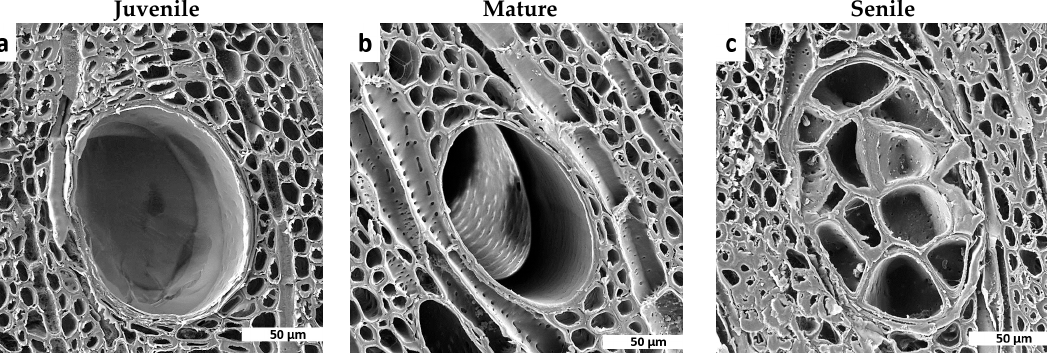
Figure 4. Microphotographs of transverse cuts obtained in scanning electron microscopy (SEM) for the comparison of green tissue-microstructure transitions in Eucalyptus globulus samples showing vessel elements embedded in abundant parenchyma cells for ( a ) juvenile, ( b ) mature and ( c ) senile samples. The transition of vessel elements with a decrease in density, roundness and sphericity, and an increase in area can be seen in the microphotographs.